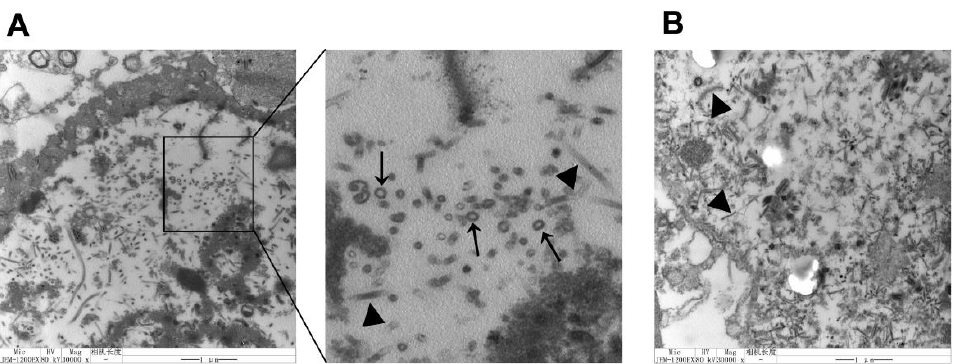
Figure 2. Identification of particle formation in Sf9 cells. Particle formation was confirmed by TEM in Sf9 cells infected with rBac-E rns +E2. Ultrathin sections of the cells showed the presence of numerous bovine viral diarrhea virus (BVDV) virus-like particles (VLPs). ( A ) Sf9 cells infected with rBac-E rns +E2 (MOI = 0.1). ( B ) Sf9 cells infected with Bac only. Images were obtained with a JEM-1200EX (Japan) transmission electron microscope at 80 kV. Black arrows point to VLPs, black arrowheads point to baculovirus, scale bar represents 1 μm.